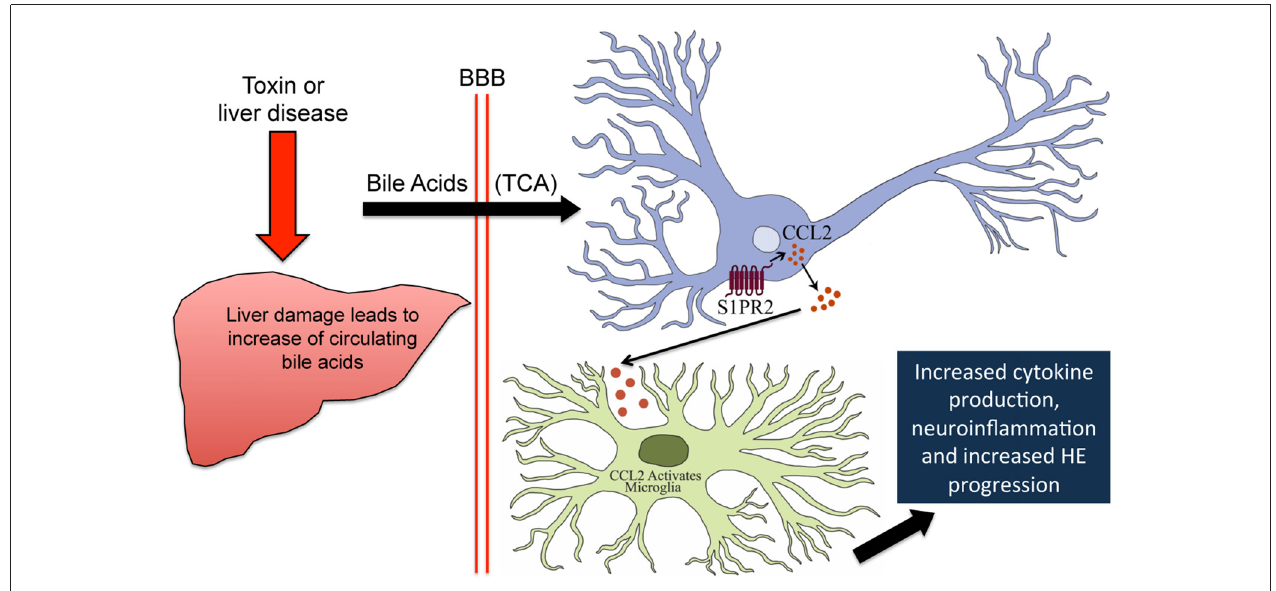
FIGURE 7 | Working model of S1PR2-mediated neuroinflammation during AOM-induced HE. AOM-induced liver failure disrupts the enterohepatic circulation and causes hepatocyte death leading to an increase of circulating bile acids including TCA. TCA crosses the leaky blood brain barrier and binds S1PR2 in neurons. This leads to increased expression and secretion of CCL2 from neurons, which binds receptors on microglia leading to their activation. This ultimately results in increased proinflammatory cytokine expression and worse HE